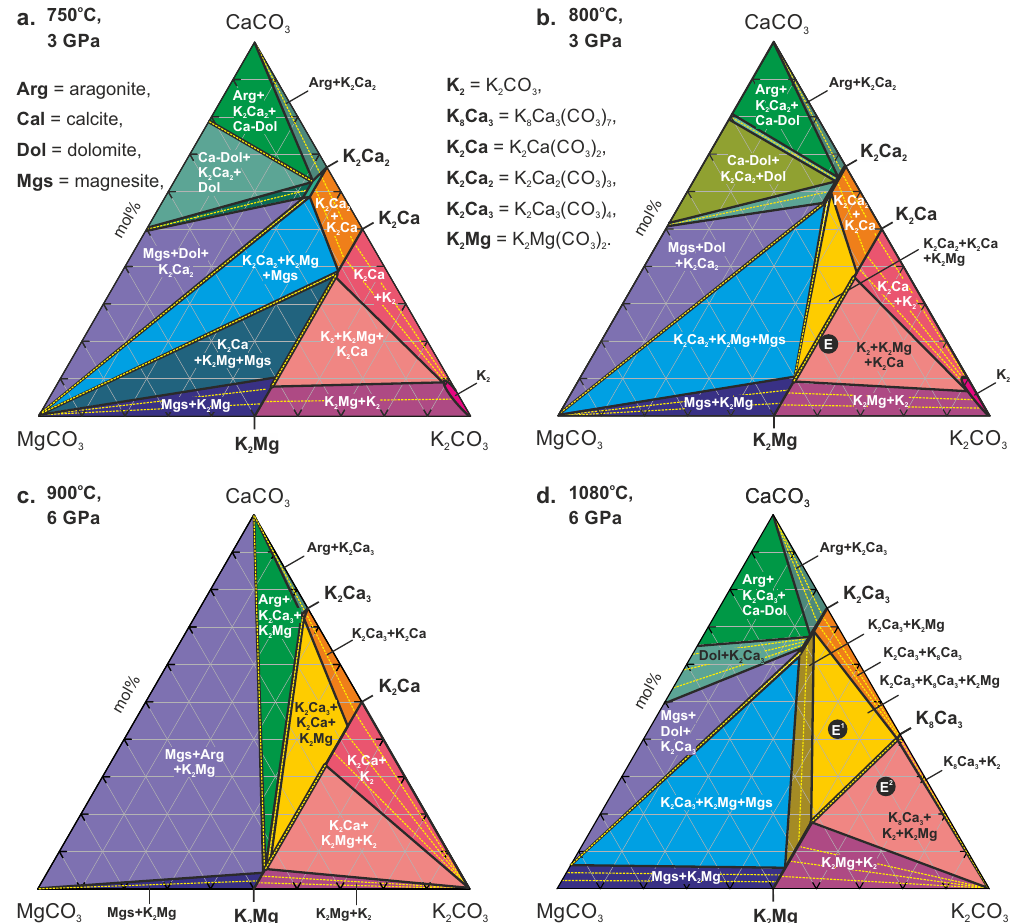
Figure 7. Isothermal and isobaric sections of the K 2 CO 3 –CaCO 3 –MgCO 3 T-X diagram at 3 GPa, 750 ◦ C ( a ) and 800 ◦ C ( b ) [37] and at 6 GPa, 900 ◦ C ( c ) and 1080 ◦ C ( d ) (this study). E, E 1 , and E 2 denote corresponding eutectic points. See the Nomenclature section for